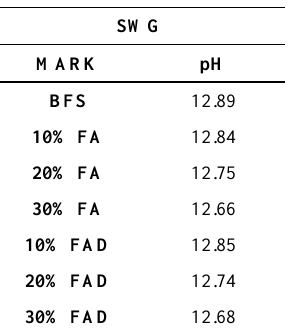
Table 7. Change of pH.